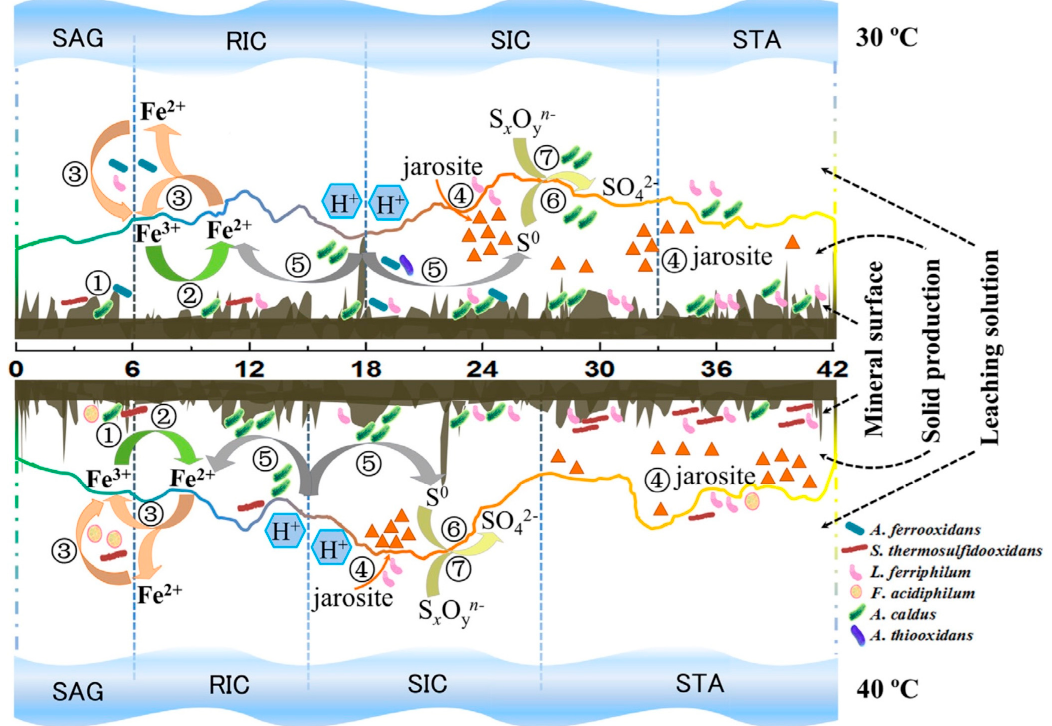
Figure 6. Mechanism model for chalcopyrite bioleaching coupling with the community succession [170]. Reproduced with permission from Ma, L.Y., Hydrometallurgy, Bioleaching of the mixed oxide-copper sulfide ore by artificial indigenous and exogenous microbial community; published by Elsevier, 2012.